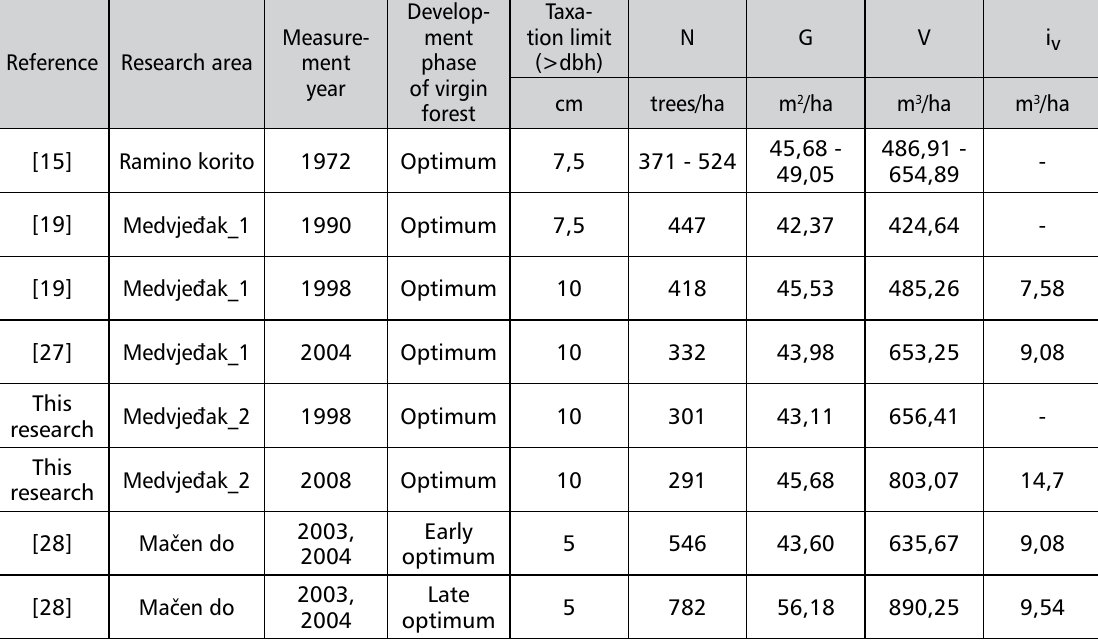
Results of stand structure elements of research conducted in optimum phase of virgin